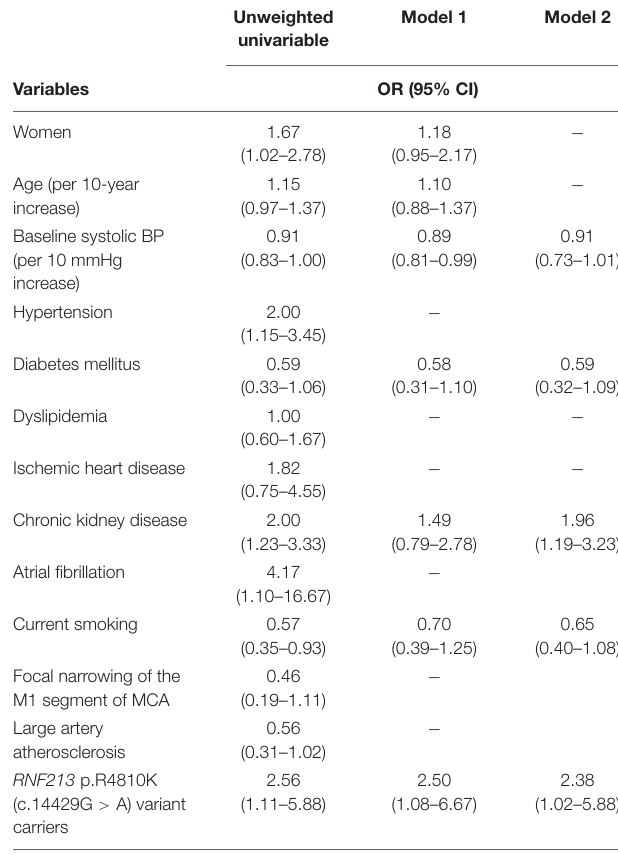
TABLE 5 | Logistic regression analyses for the absence of AComA.